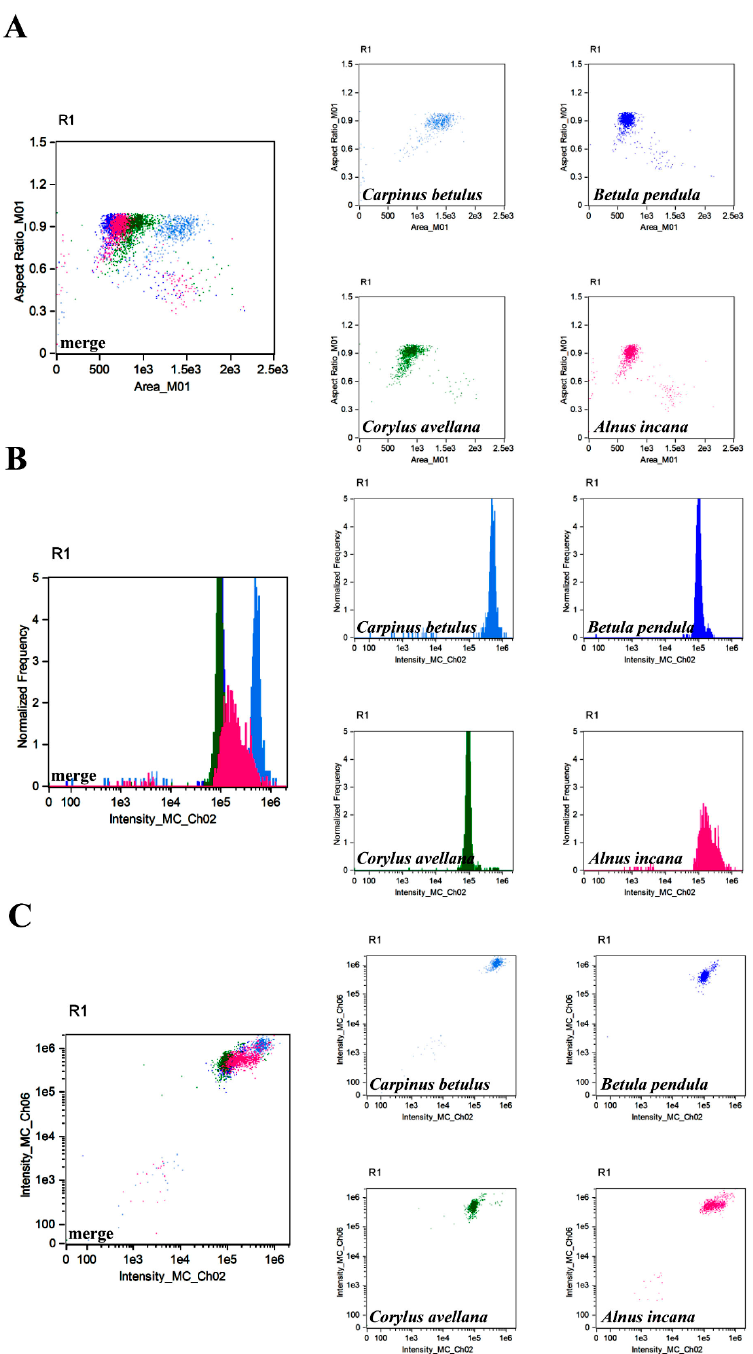
Figure 6. Colocalisation analysis of four species of trees belonging to the Betulaceae family using IFC. Three types of analysis (different parameters) were considered, namely the parameter ‘aspect ratio’ in channel 1 (BF, y -axis) versus ‘area’ parameter (channel 1, BF, x -axis) ( A ), ‘normalized frequency’ parameter (channel 1, BF, y -axis) versus fluorescence ‘intensity’ parameter in channel 2 ( x -axis) ( B ) and the ‘intensity’ fluorescence parameter (channel 6, SSC, y -axis) versus fluorescence ‘intensity’ parameter (channel 2, x -axis) ( C ). Carpinus betulus (blue), Betula pendula (navy blue), Corylus avellana (green), and Alnus incana (pink) separate profiles and merged profiles are